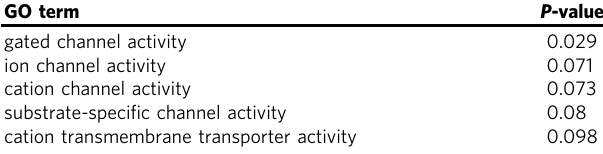
Table 4 Functional annotation of eQTL study results for our susceptibility GWAS GO terms with a threshold of P value <